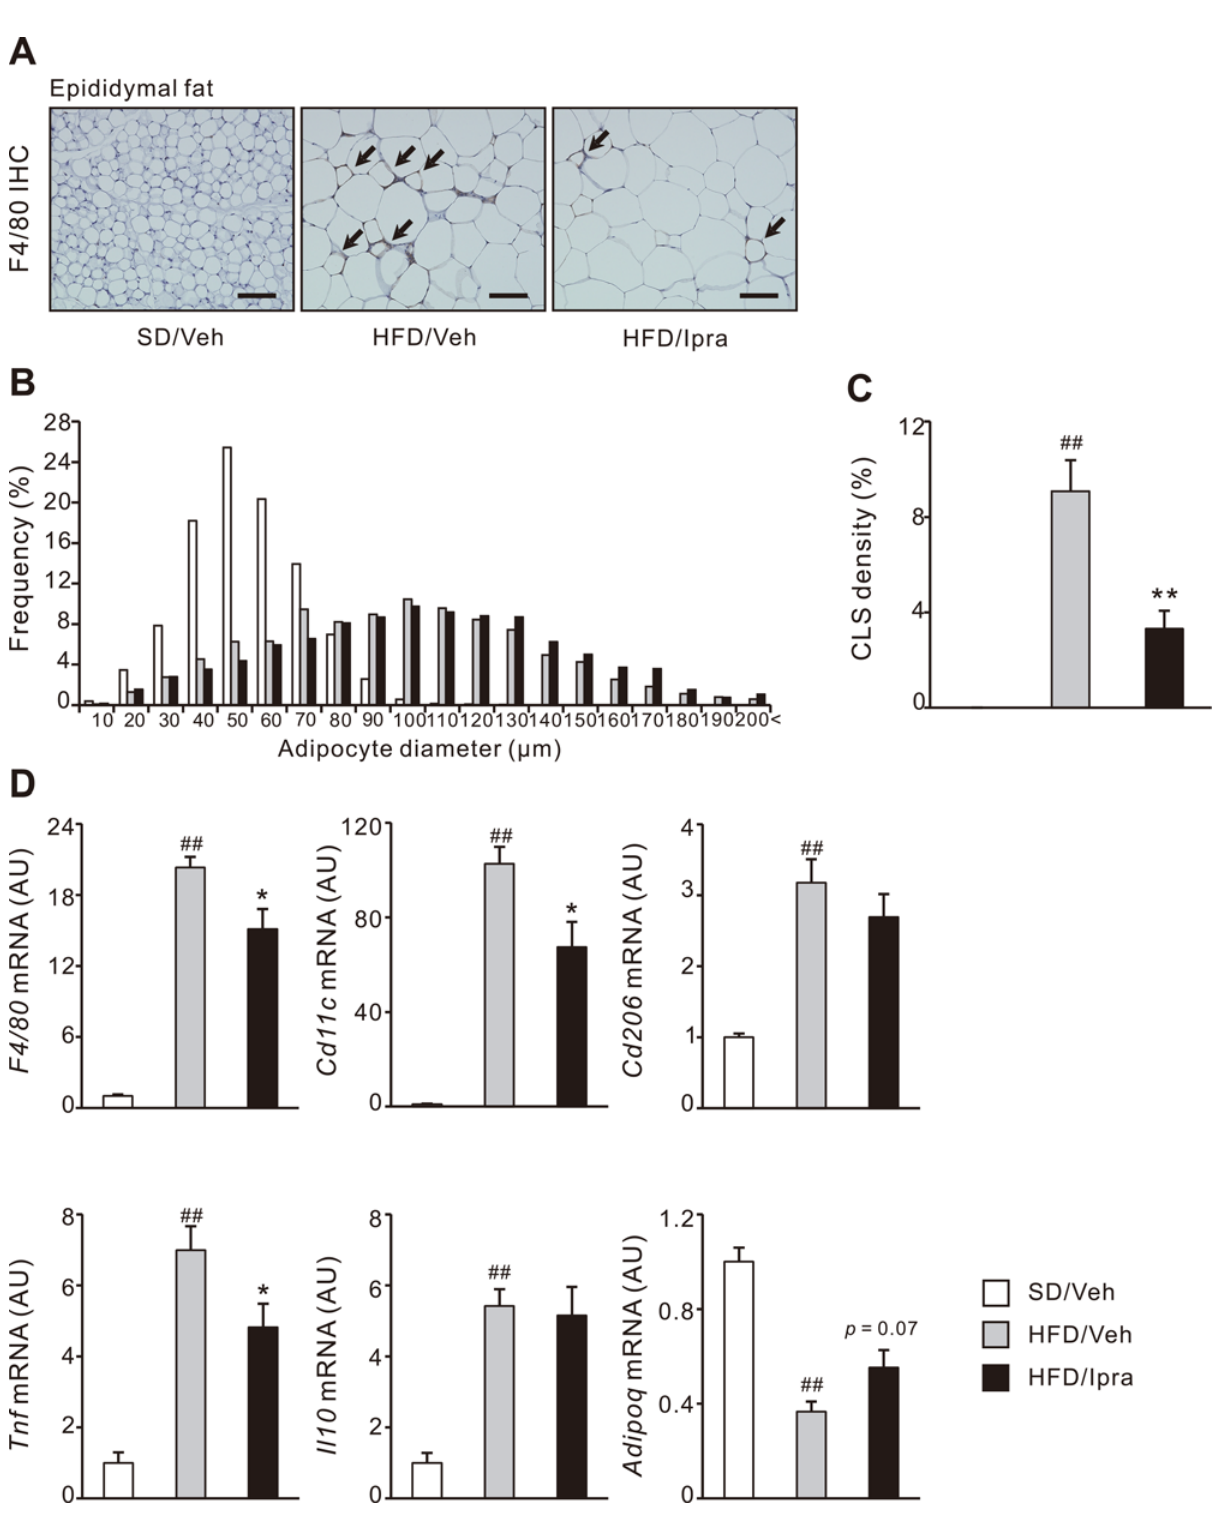
Fig 3. Effect of ipragliflozin on adipose tissue inflammation in HFD-fed WT mice. (A) F4/80 immunohistochemistry of the epididymal fat sections after 4 weeks of the vehicle or ipragliflozin treatment. Arrows indicate CLS. (B) Histogram of adipocyte diameter and (C) quantification of CLS density in the epididymal fat. (D) Gene expression levels in the epididymal fat associated with inflammation and adipocytokines. Original magnification, × 200. Scale bars, 100 μ m. # p < 0.05, ## p < 0.01 vs SD/Veh; * p < 0.05, ** p < 0.01 vs HFD/Veh. n = 6 – 8.